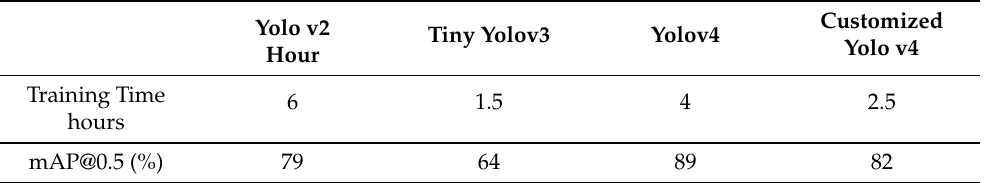
Table 5. Comparison of mAP of our customized Yolo v4 with three other variants of same family including Yolov2, Tiny Yolov3, baseline Yolov4 and customized Yolo v4.